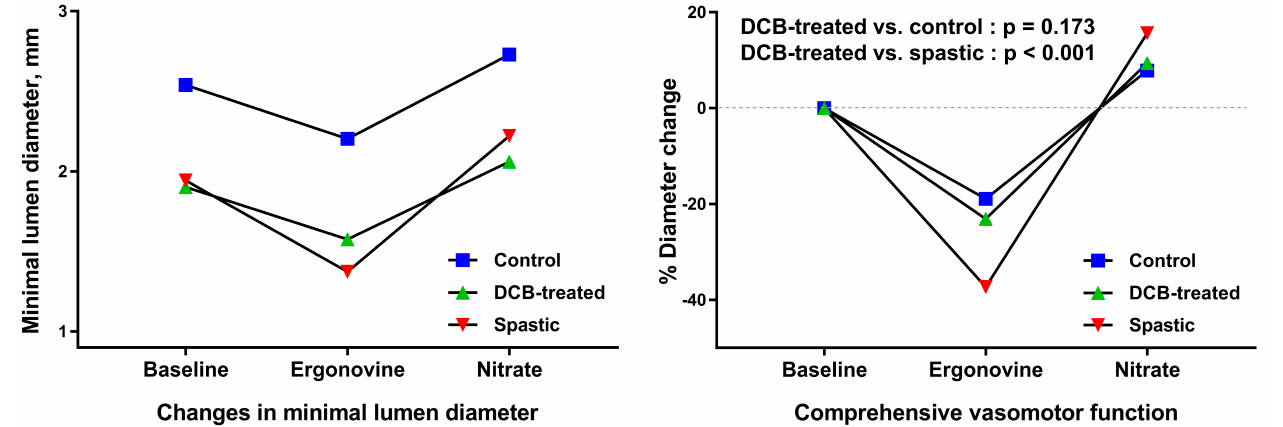
Figure 5. Comparison of serially assessed vasomotor response to ergonovine and nitrate between the three comparative